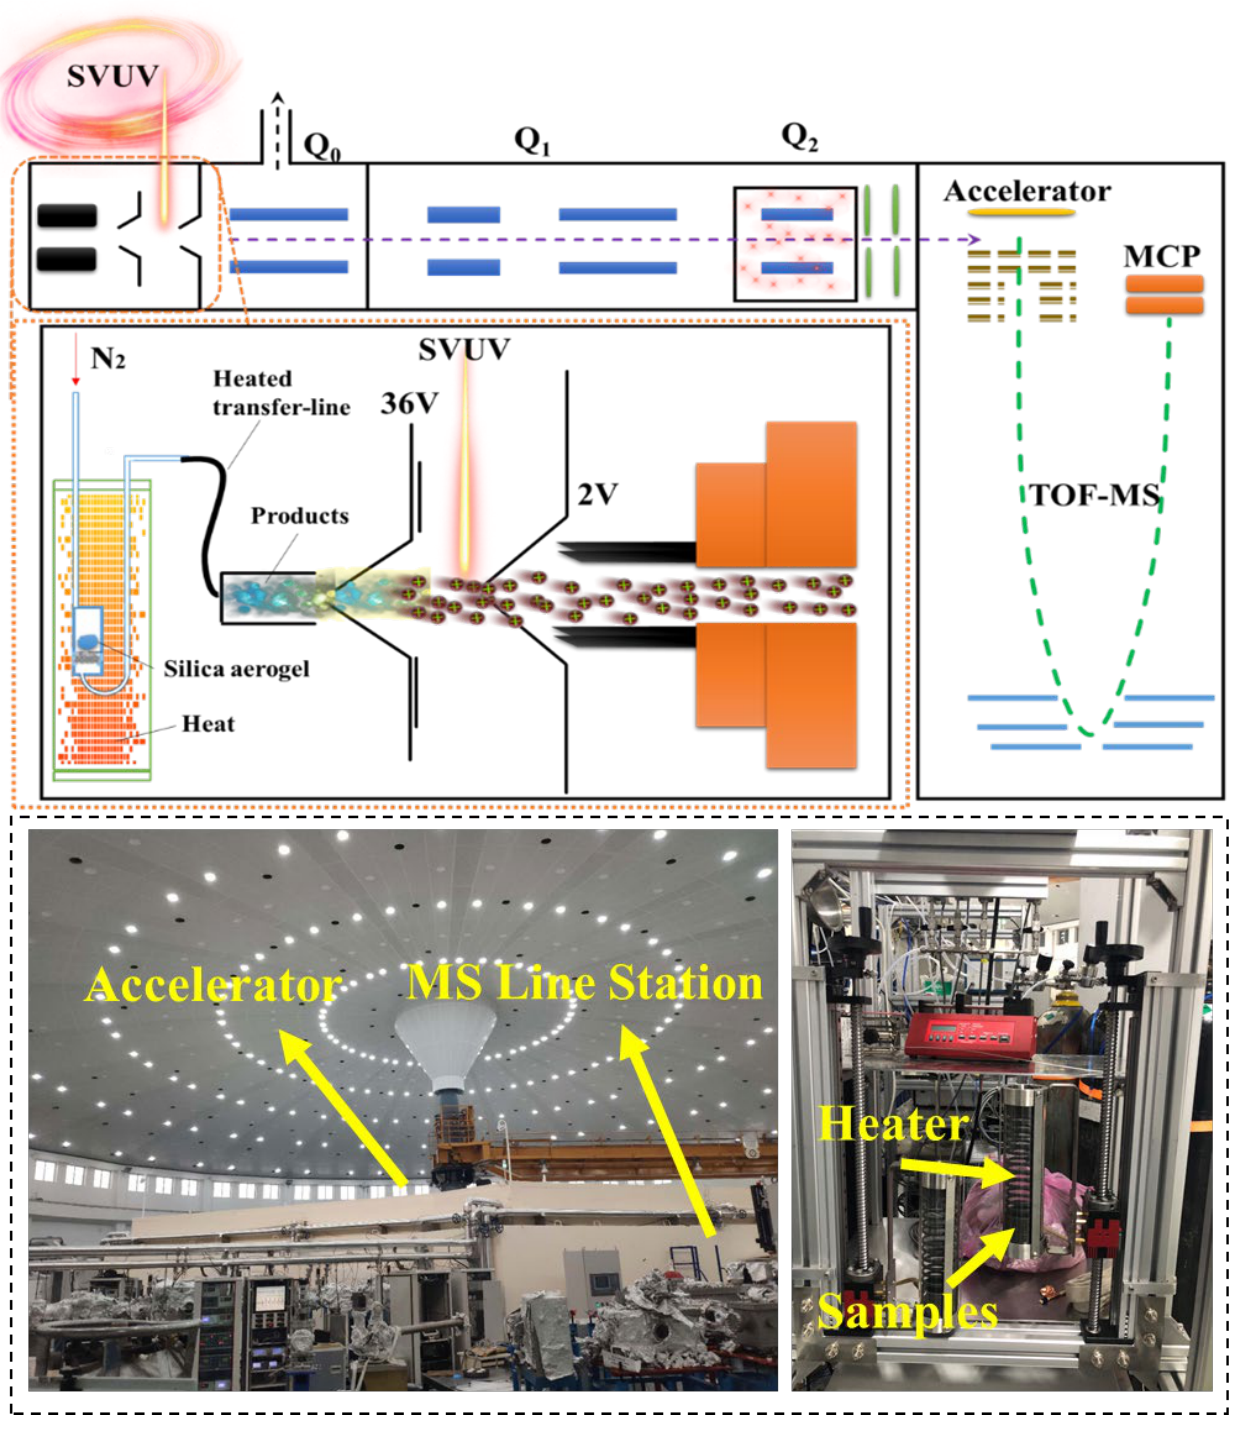
Figure 5. Experiment equipment of SVUV-PIMS analysis.